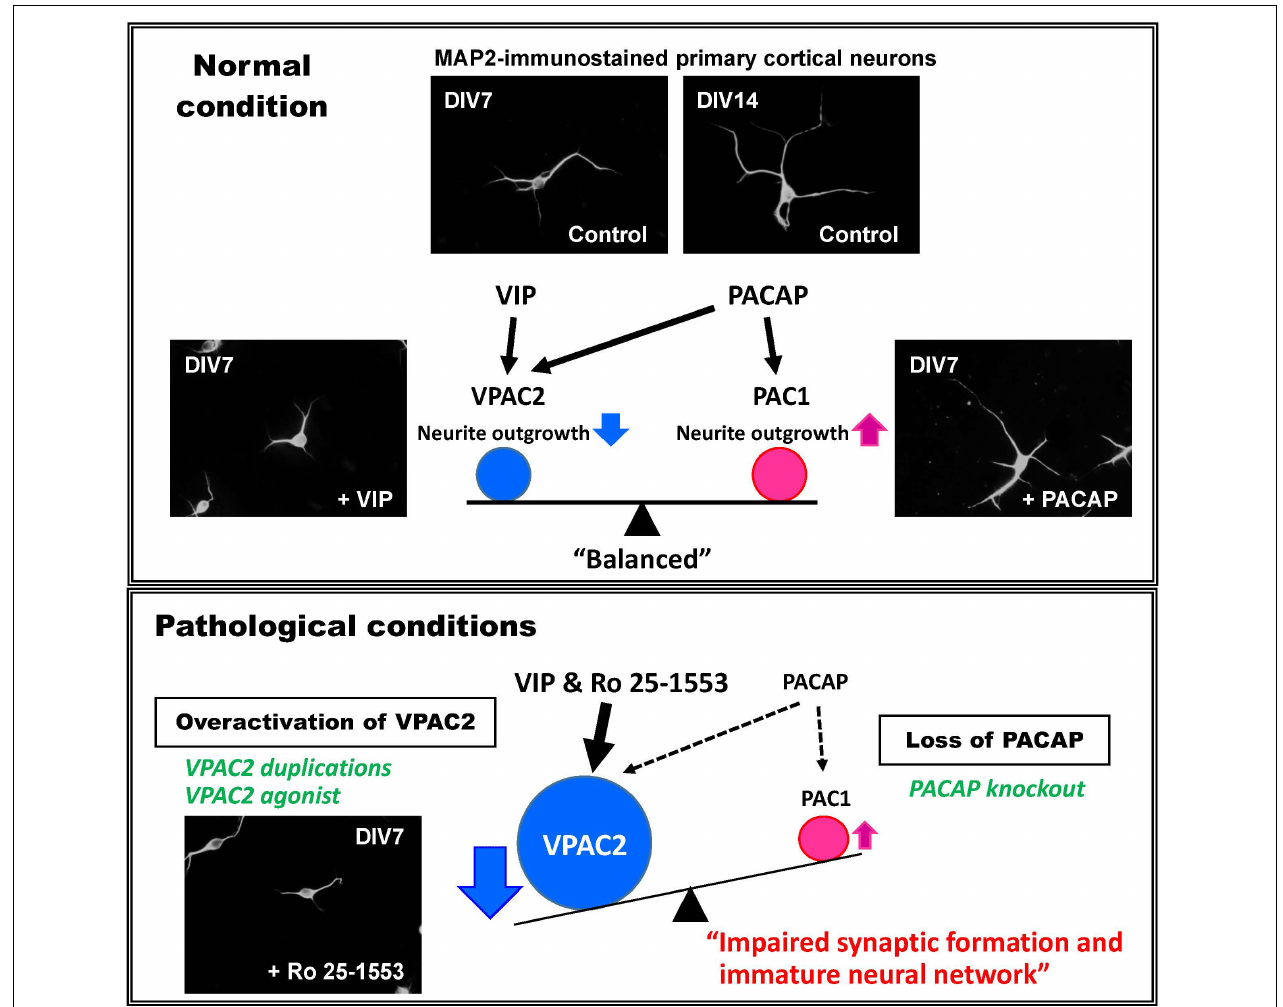
FIGURE 1 | Proposed mechanism for the roles of VIP and PACAP system in neural development and mental health disorders. Mouse primary embryonic cortical neurons extend axons and dendrites in vitro in the absence of added peptide. Addition of VIP results in a reduction in total numbers and lengths of neuronal dendrites via the VPAC2 receptor, whereas PACAP selectively facilitates the elongation of dendrites via the PAC1 receptor (Takeuchi et al., 2020). To explain these differential effects, it is proposed that VPAC2 and PAC1 signaling undergoes differential timed activations in brain development under normal (physiological) conditions. When the VPAC2 receptor activity is enhanced by VIPR2 duplications or by pharmacological activation, or if PACAP–PAC1 signaling is reduced by PACAP deficiency, the VPAC2 signaling would be expected to become relatively amplified. This might cause the delay of neural maturation and thus impaired synaptic function, leading to brain